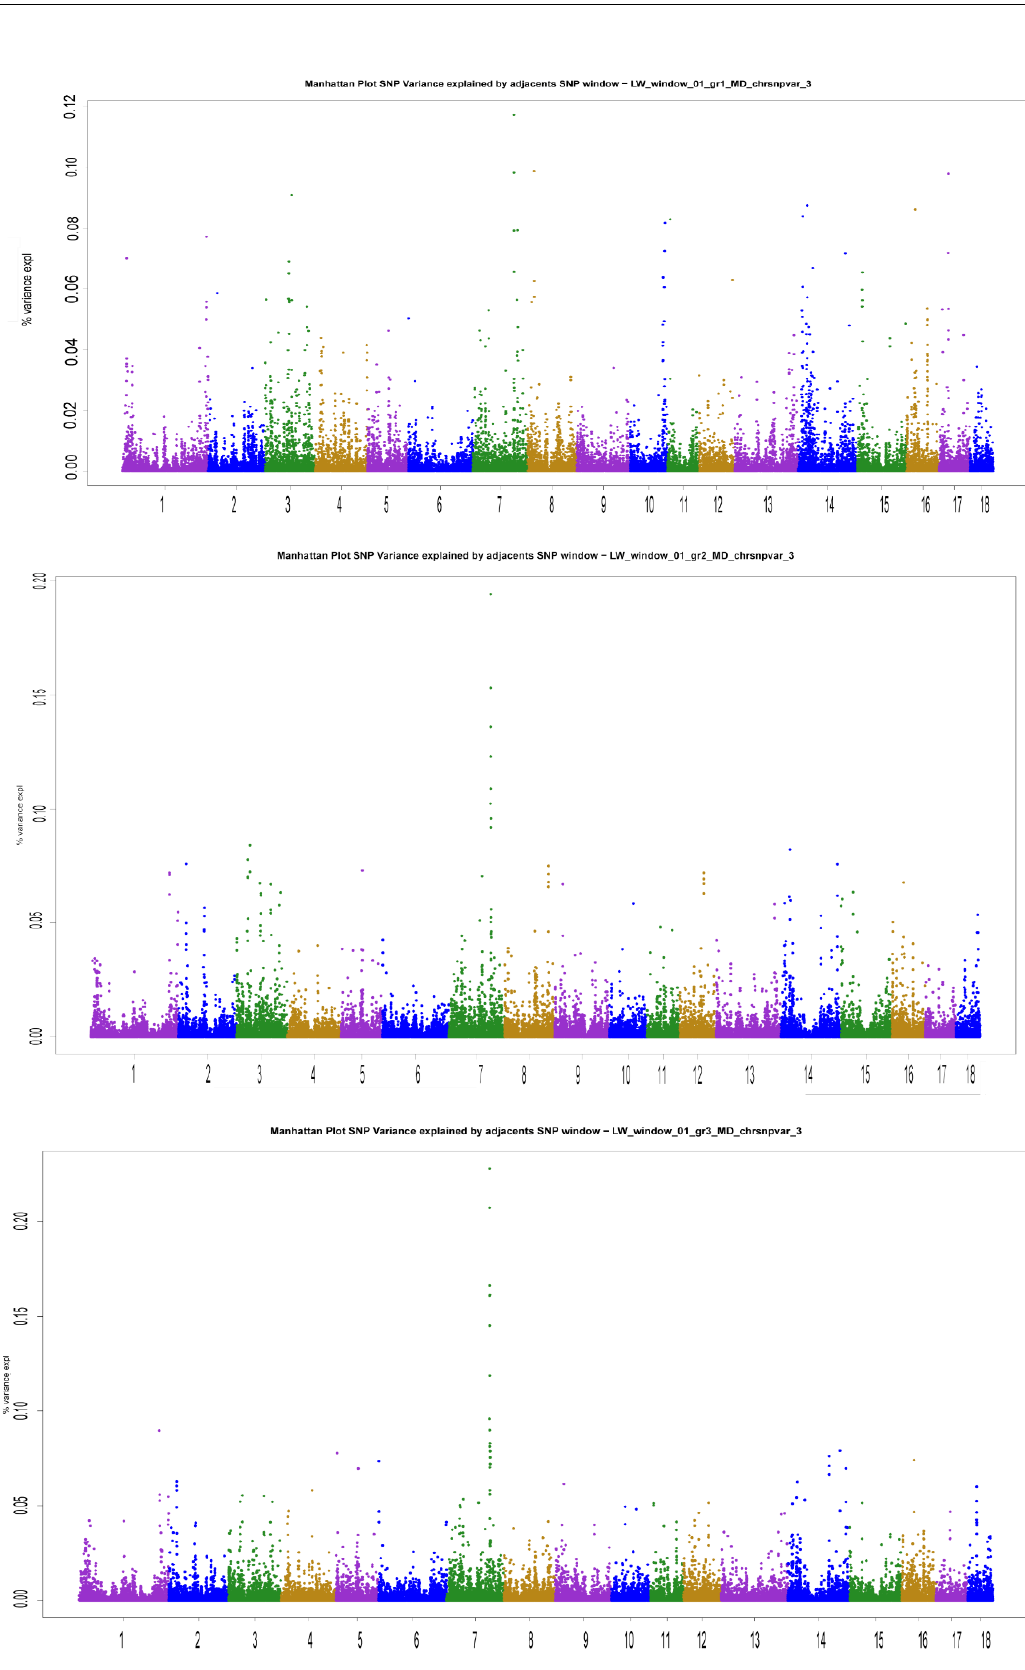
Figure 1. Manhattan plots of muscle depth (MD) variance explained by SNP markers based on Scenarios 1–3 ( a —Scenario 1, b —Scenario 2, c —Scenario 3)